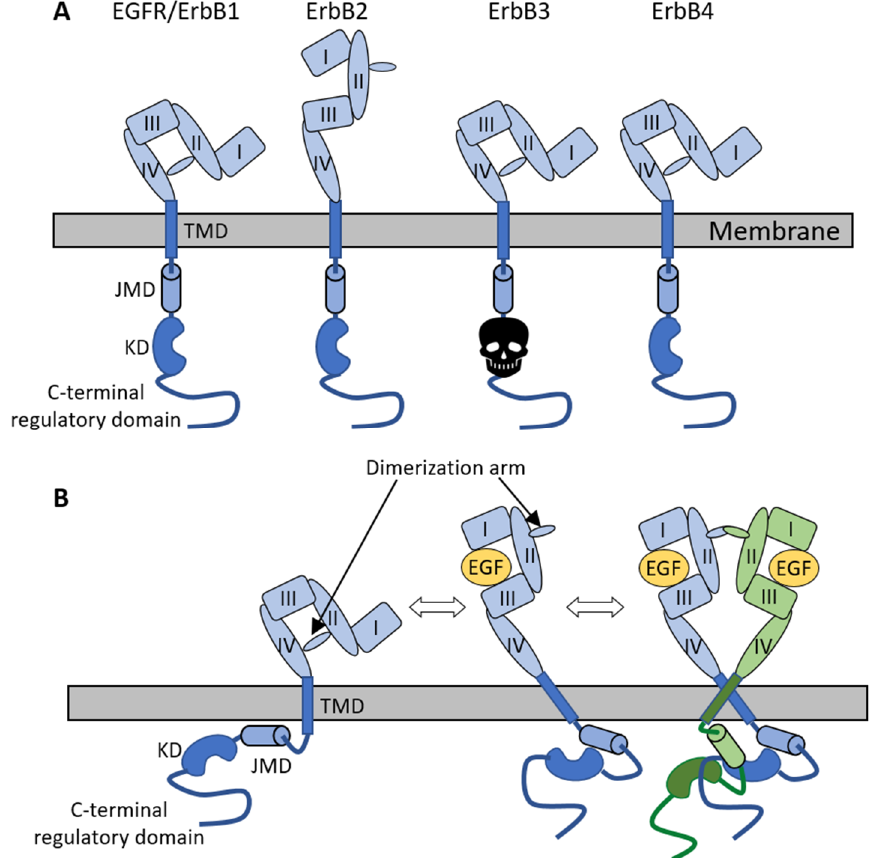
Figure 1. Domain organization and activation of ErbB receptors. ( A ) All four members of the ErbB family follow the same domain organization. Panel A displays the receptors in the absence of ligand. The extracellular domain (ECD) adopts a closed conformation in EGFR, ErbB3, and ErbB4. Although the ECD of ErbB2 assumes an extended structure with the dimerization arm exposed, several autoinhibitory interactions have been identified in it (not shown in the figure). The ligand- binding pocket of ErbB2 is constrained, preventing the binding of growth factors. The extracellular portion is followed by the transmembrane domain (TMD), and by the juxtamembrane (JMD), the kinase (KD), and the C-terminal regulatory domains on the intracellular side. Due to mutations in